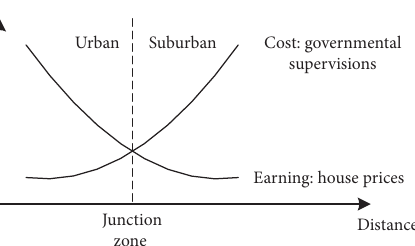
Figure 10: The flow diagram of CA layer.